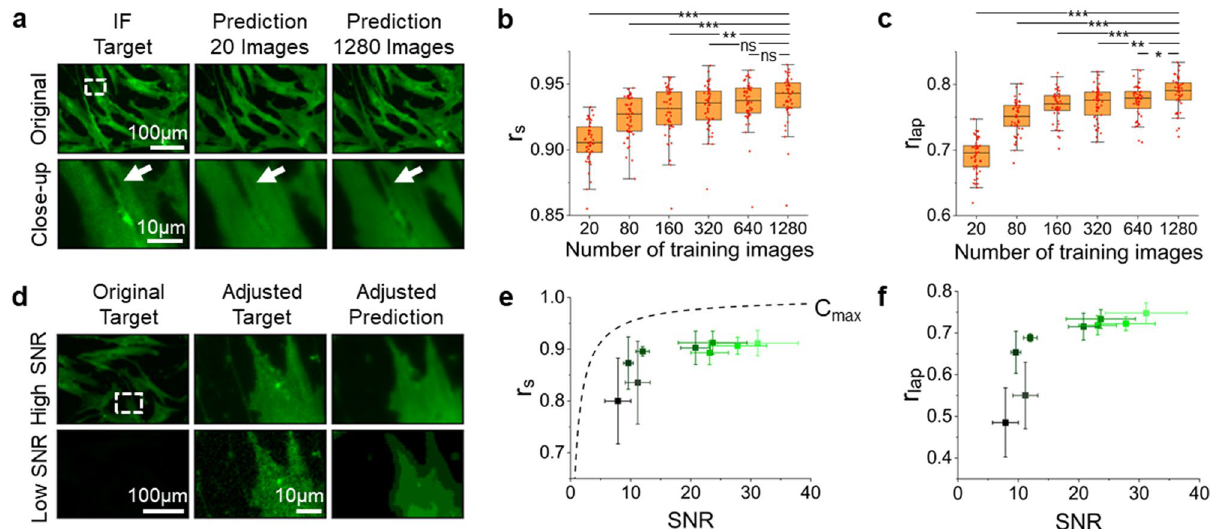
Figure 2. Characterization and robustness analysis of the proposed ML model with CD105 staining. ( a ) Comparison of a target image with prediction images resulting from a model trained with 20 or 1280 images. The ML training set consisting of 20 images accurately predicts boundaries of cells but fails to identify small spindle-like subcellular structures (arrows). ( b , c ) Performance of fluorescence image predictions measured by image-wise Source and Laplacian Pearson correlation coefficients as a function of the number of training images. A higher number of training images improve the predictions of details and rare events. For both boxplots, ns stands for not significant; *p < 0.05; **p < 0.001; ***p < 0.0001. ( d ) Simulating weakly expressed markers with step-wise lowering illumination. The first column displays immunofluorescent target images and the second and third columns represent a magnified target and prediction image, respectively, with adjusted brightness for better visualization. ( e , f ) Prediction performance across different excitation levels. Dim markers can be represented fairly robustly by our AI algorithm, with prediction differences primarily visible for small scale features such as detailed protein localization and fine morphological shapes. Dashed line in ( e ) indicates the theoretical maximum correlation between the target and optimal prediction images ( C max ). Error bars represent the standard deviation of the mean. All box and point plots were created by using OriginLab version